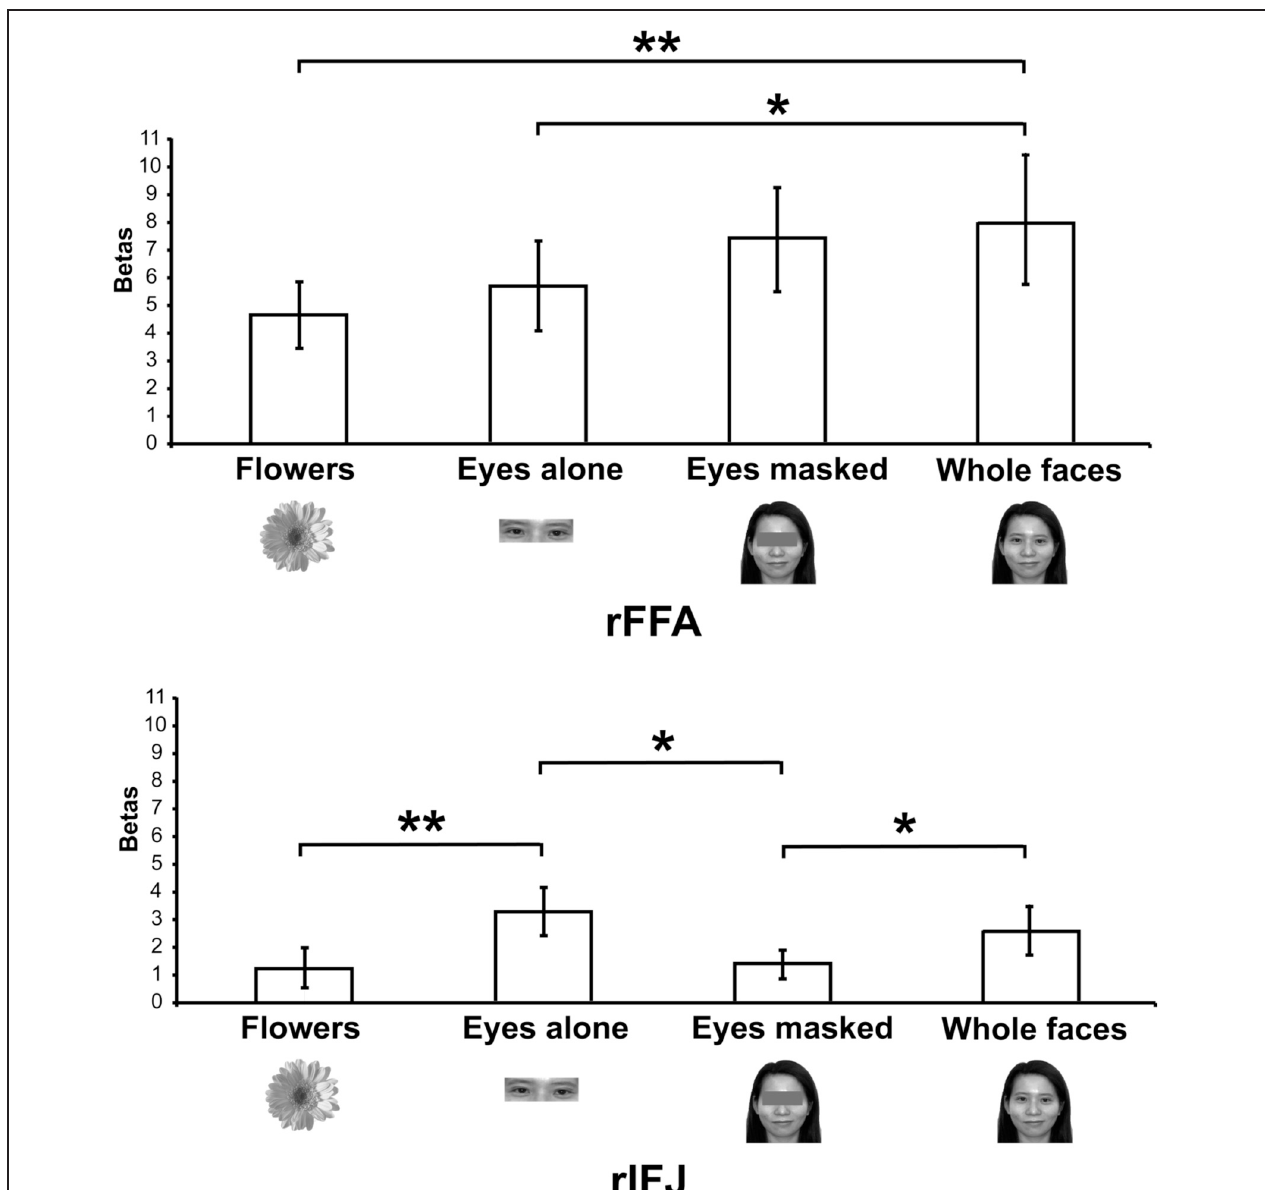
FIGURE 4 | Responses of rFFA and rIFJ, based on independent functional localizers, to flowers, whole faces, eyes, and faces with eyes masked. Conventions as in Figure 2 . Asterisks indicate significant differences between conditions: ∗ p < 0 . 05; ∗∗ p < 0 .